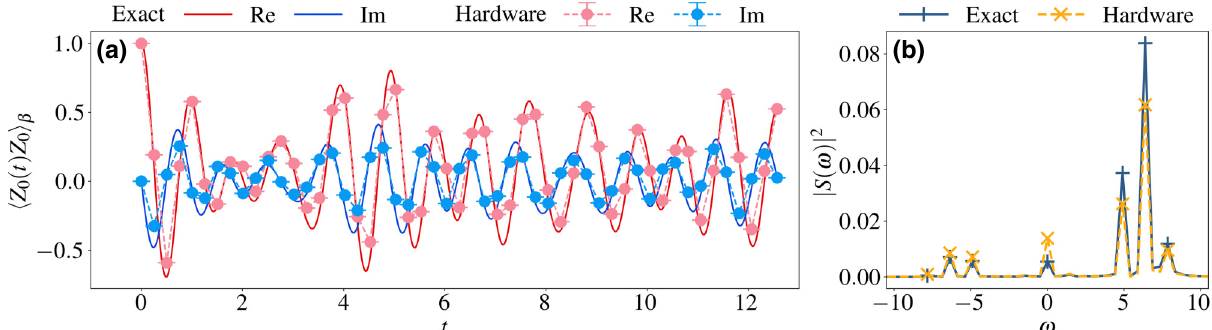
FIG. 10. Finite-temperature dynamical properties of the four-site TFIM with J = 3, h = 1 at β = 0.2. QITE is performed with a time step of (cid:3)τ = 0.05 and recompiled D = 2 unitaries. (a) Real and imaginary parts of the finite-temperature dynamical correlation function (cid:9) Z 0 ( t ) Z 0 (cid:7) β versus real time t . Raw hardware data are postprocessed by phase-and-scale correction. (b) Finite-temperature excitation spectra obtained by Fourier transform of exact and phase-and-scale-corrected hardware (cid:9) Z 0 ( t ) Z 0 (cid:7) β at the same points in real time. The hardware (cid:9) Z 0 ( t ) Z 0 (cid:7) β and excitation spectrum after phase-and-scale correction are in good agreement with the exact